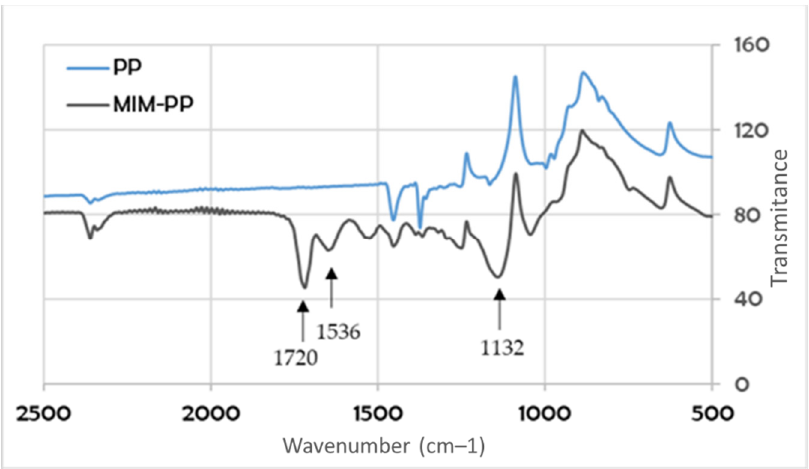
Figure 6. Infrared ( IR) spectrum of a non-modified polypropylene (PP) and a modified molecularly imprinted membrane - polypropylene (MIM-PP), G-series.